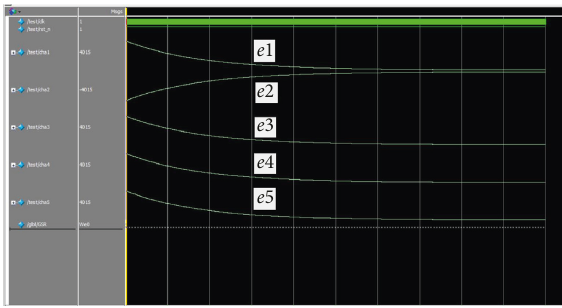
Figure 16: The trajectories of the synchronization errors , e , e ,e , and e e based on 1 2 3 4 5